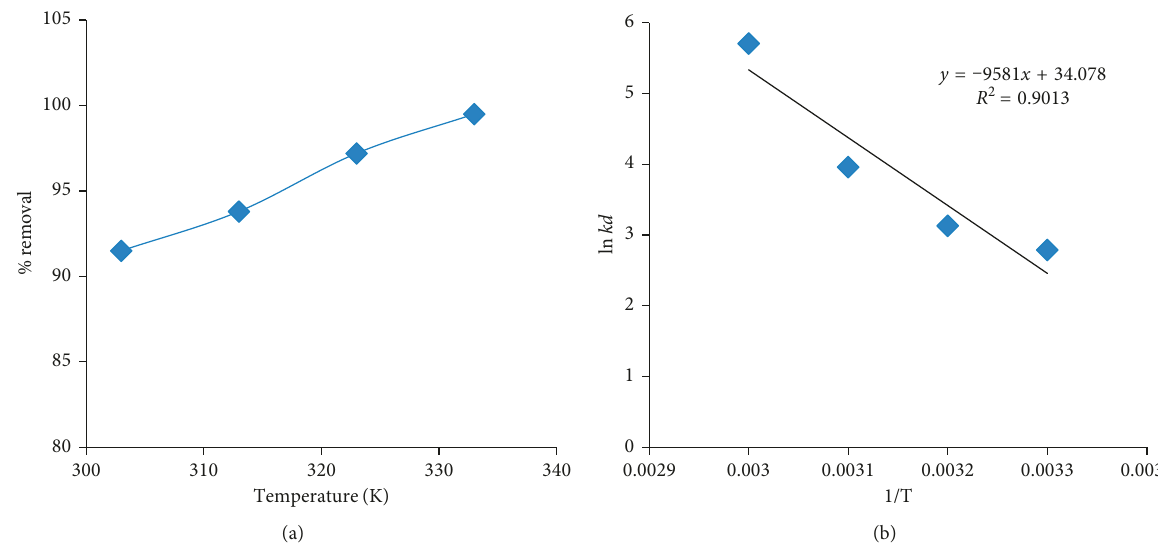
Figure 12: (a) Effect of interfering temperature on adsorption of lead. (b) Effect of interfering cations on adsorption of